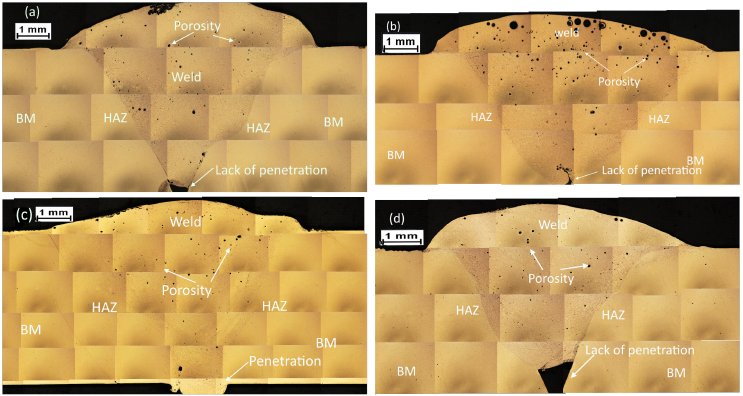
Figure 8. Macrostructure of selected samples: ( a ) M2, the best from AA6061–T6 reached 104 MPa; ( b ) M3, the worst from AA6061–T6, 54 MPa; ( c ) M6, the best from AA6061–T4, 117 MPa; and ( d ) M8, the worst from AA6061–T4, 80